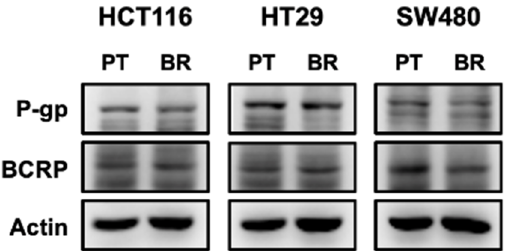
Figure 2. Effects of butyrate resistance on drug efflux pump expression. Expression of P-glycoprotein (P-gp) and breast cancer resistance protein (BCRP) was determined by immunoblot analysis. Actin was used as an internal control. This was repeated in three independent experiments.